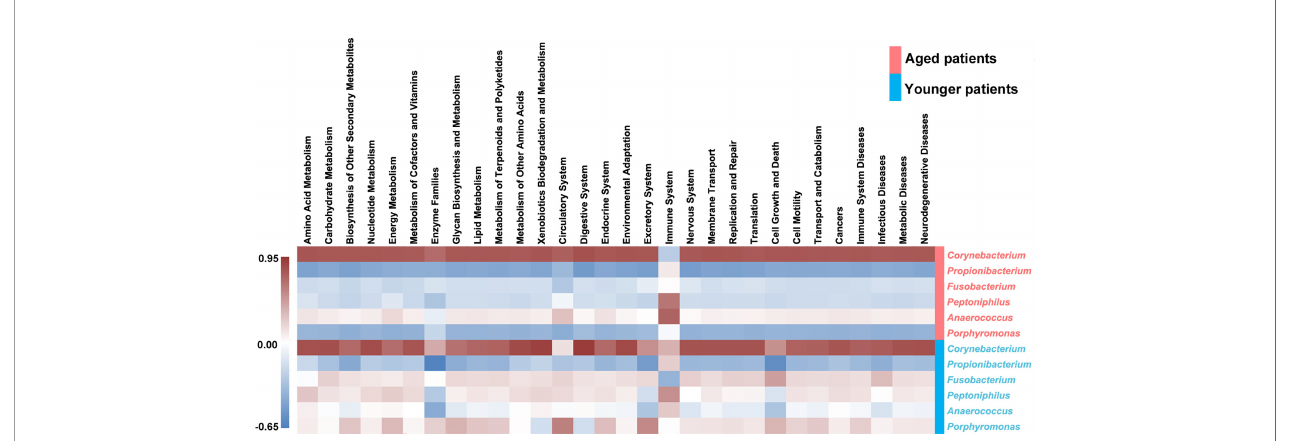
FIGURE 8 | Heat map of the correlations between the differential abundant genus and the top 30 abundant secondary metabolic pathways. The Pearson correlation coef fi cient between the differential genus and the metabolic pathway was calculated, and the correlation coef fi cient matrix of the differential genus-metabolic pathway was obtained, and the matrix heat map was drawing by R language. Red represents a positive correlation, blue represents a negative correlation, and the darker the color, the greater the